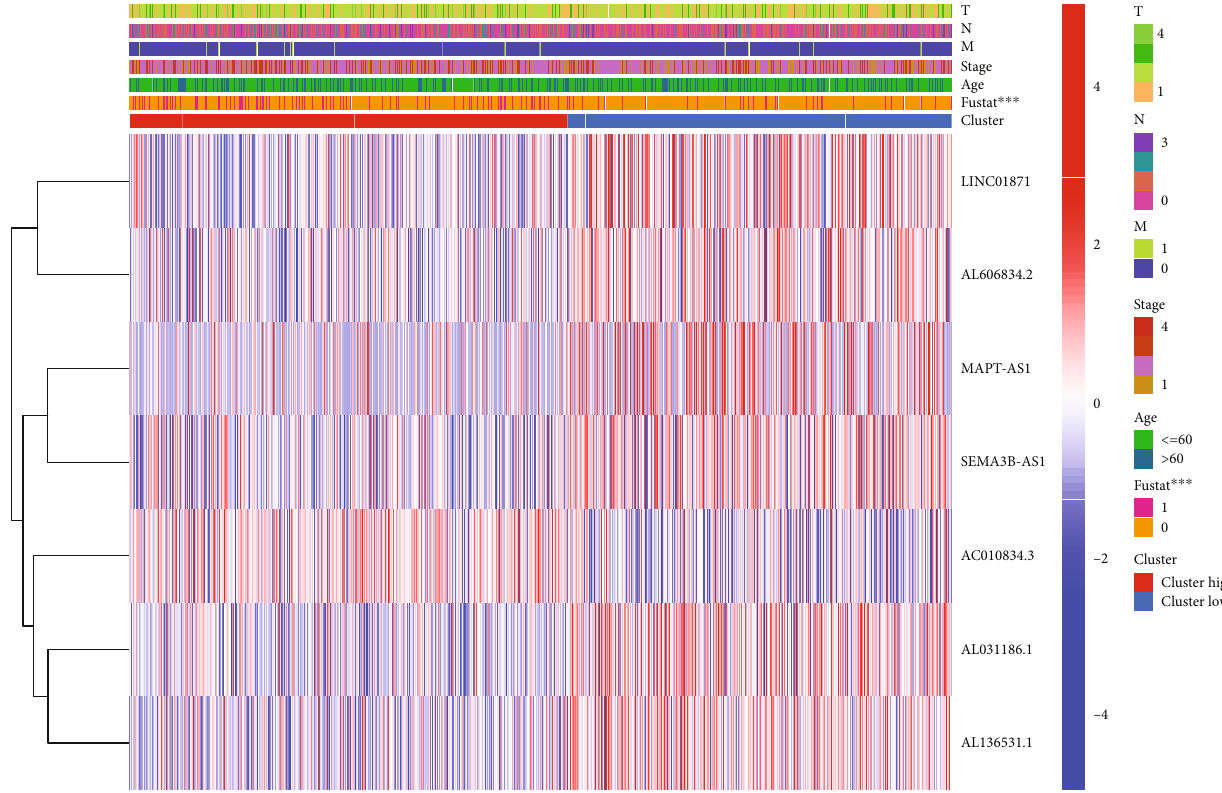
Figure 7: A heat map of the distribution of seven prognostic necroptosis-related lncRNAs and clinical factors was